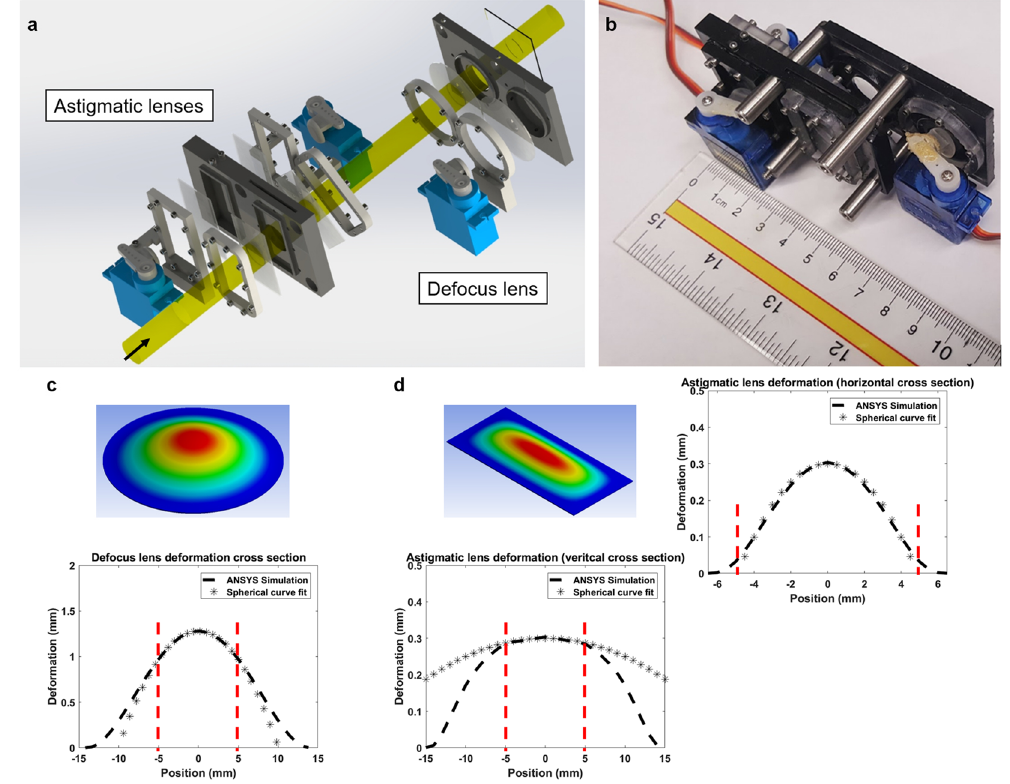
Figure 2. Fluidic lens package. (a) Exploded view of the tunable fluidic lenses and pumps. Each lens is controlled using a diaphragm pump that is actuated using a servo motor. The pump diaphragm is made of the same PDMS as the lens membranes. Yellow color illustrates the light path through the lenses. (b) The assembled setup including 3D printed structures. (c) The simulated membrane deformation for the defocus lens. The fitted spherical curve (40 mm radius) onto the deformation cross section shows that the membrane acts as a spherical surface within the 10 mm diameter optical aperture that is illustrated by the red dashed lines. (d) Simulated data for the rectangular membrane fitted with a 40 mm radius curve (10-diopter lens) in the horizontal cross section. Since the radius of curvature in the vertical orientation (1000 mm) is much larger than the horizontal direction, the surface acts as a cylindrical membrane within the optical